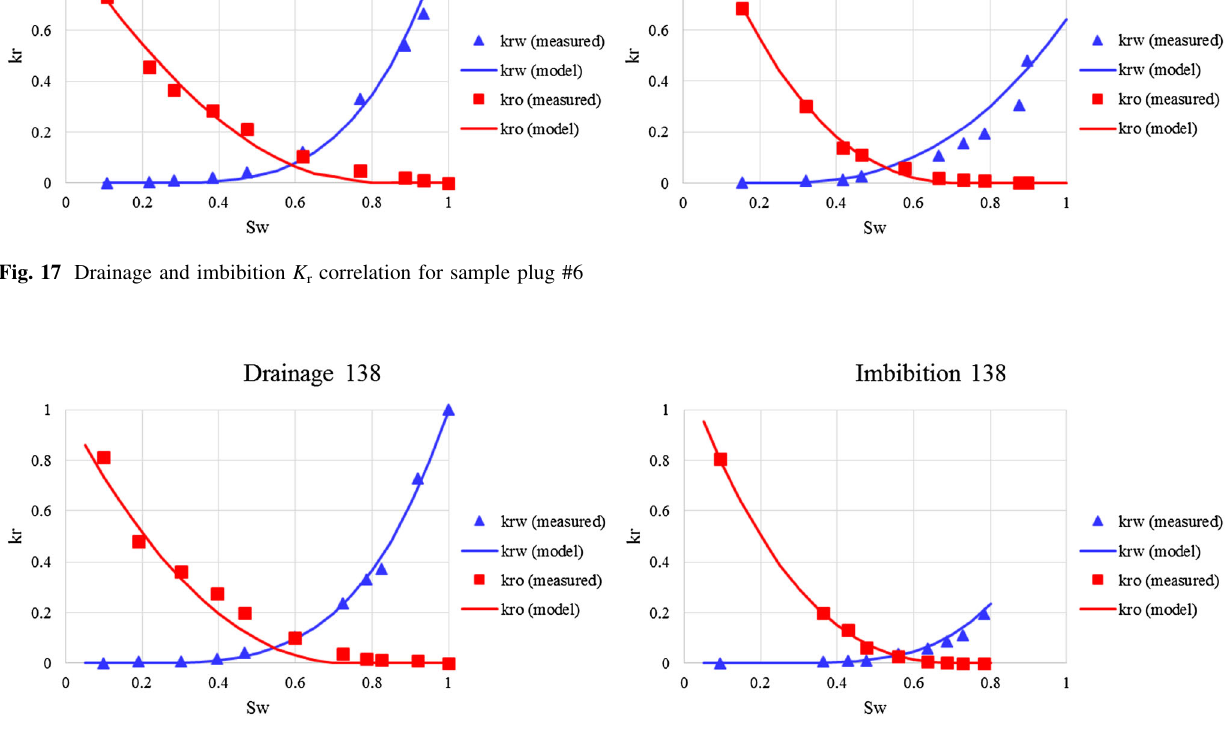
Fig. 18 Drainage and imbibition K r correlation for sample plug